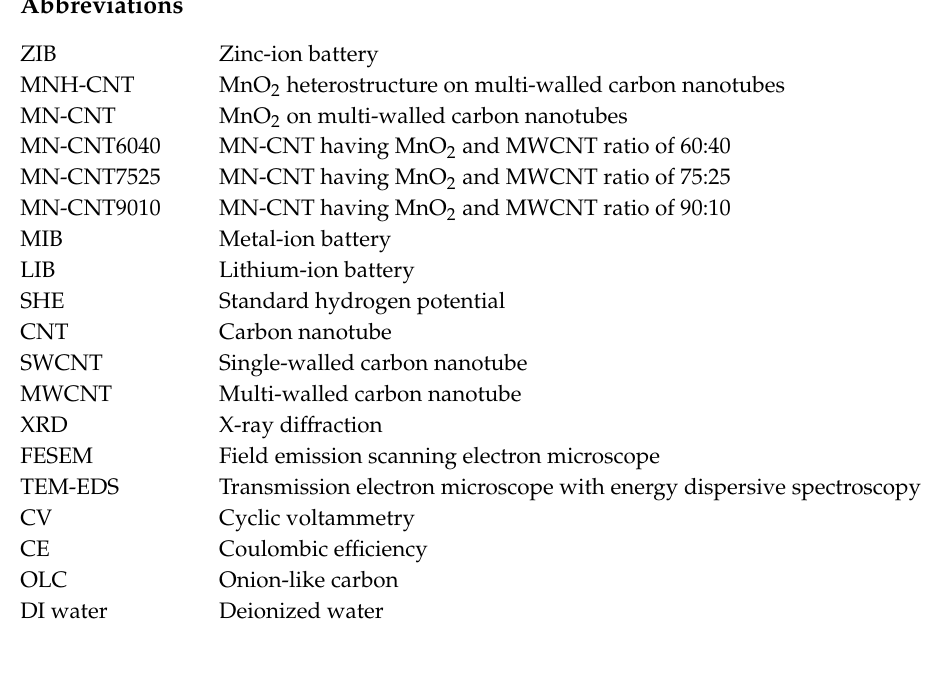
s1. Figure S1. FESEM images at low magnification of (a) MN-CNT9010; (b) MN-CNT7525 and(c) MN-CNT6040. Figure S2. TEM images of (a) MN-CNT9010 (b) MN-CNT7525 and(c) MN-CNT6040. Figure S3. TEM-EDS of